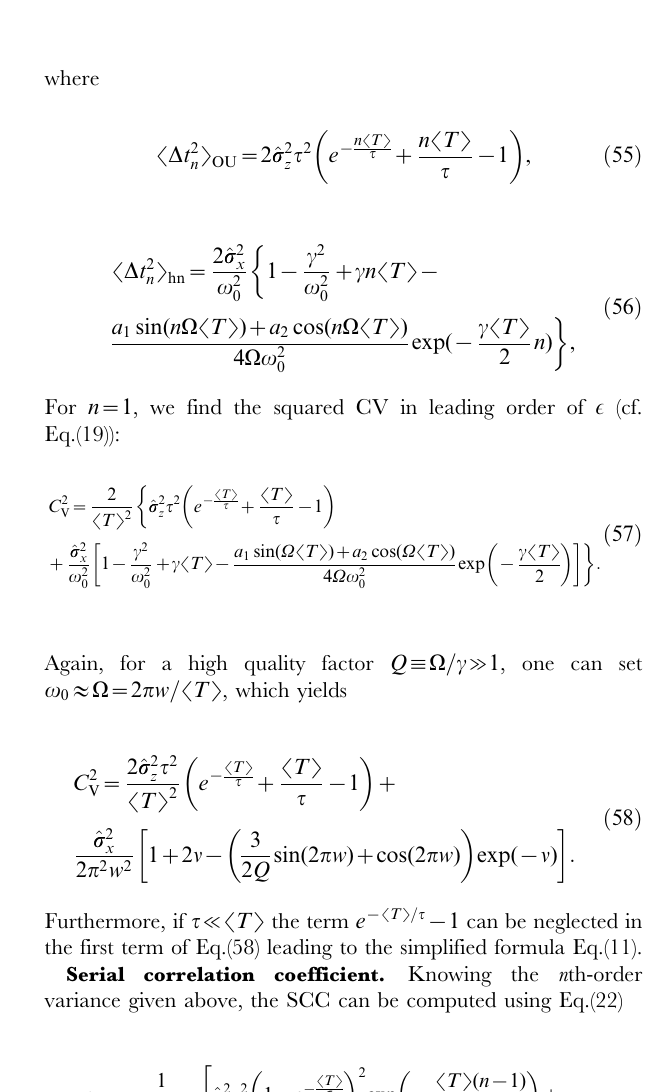
Figure 10. Comparison of ISI statistics from numerical simulation and theory versus noise strength E ~ ^ ss x for different values of the frequency ratio w as indicated in the legends: coefficient of variation (A) with a double logarithmic plot of the same data in the inset, skewness of ISI density (B), and serial correlation coefficient at lag one (C). Remaining parameters: Q ~ 30 , ^ ss z ~ 0 , m ~ 1 , and v T ~ 1 .